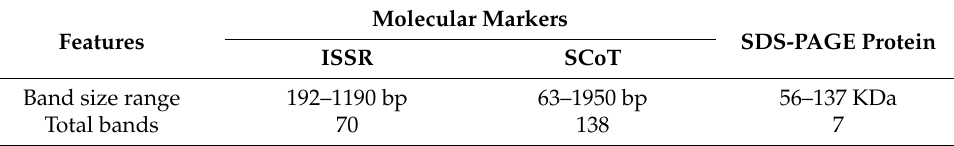
Table 3. Number of primers, size range, total bands and polymorphic bands produced by ISSR and SCoT markers used in this